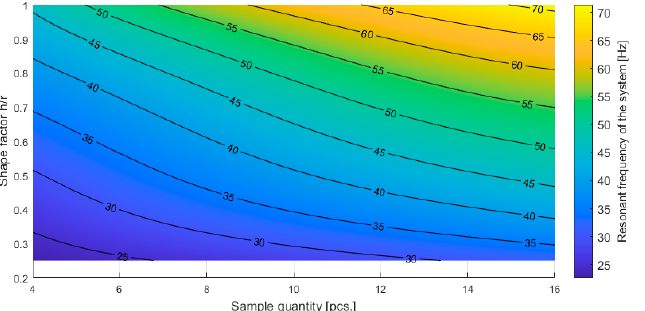
Figure 12. Resonant frequency of the tested system as a function of the quantity of the sample and shape factor of individual samples.